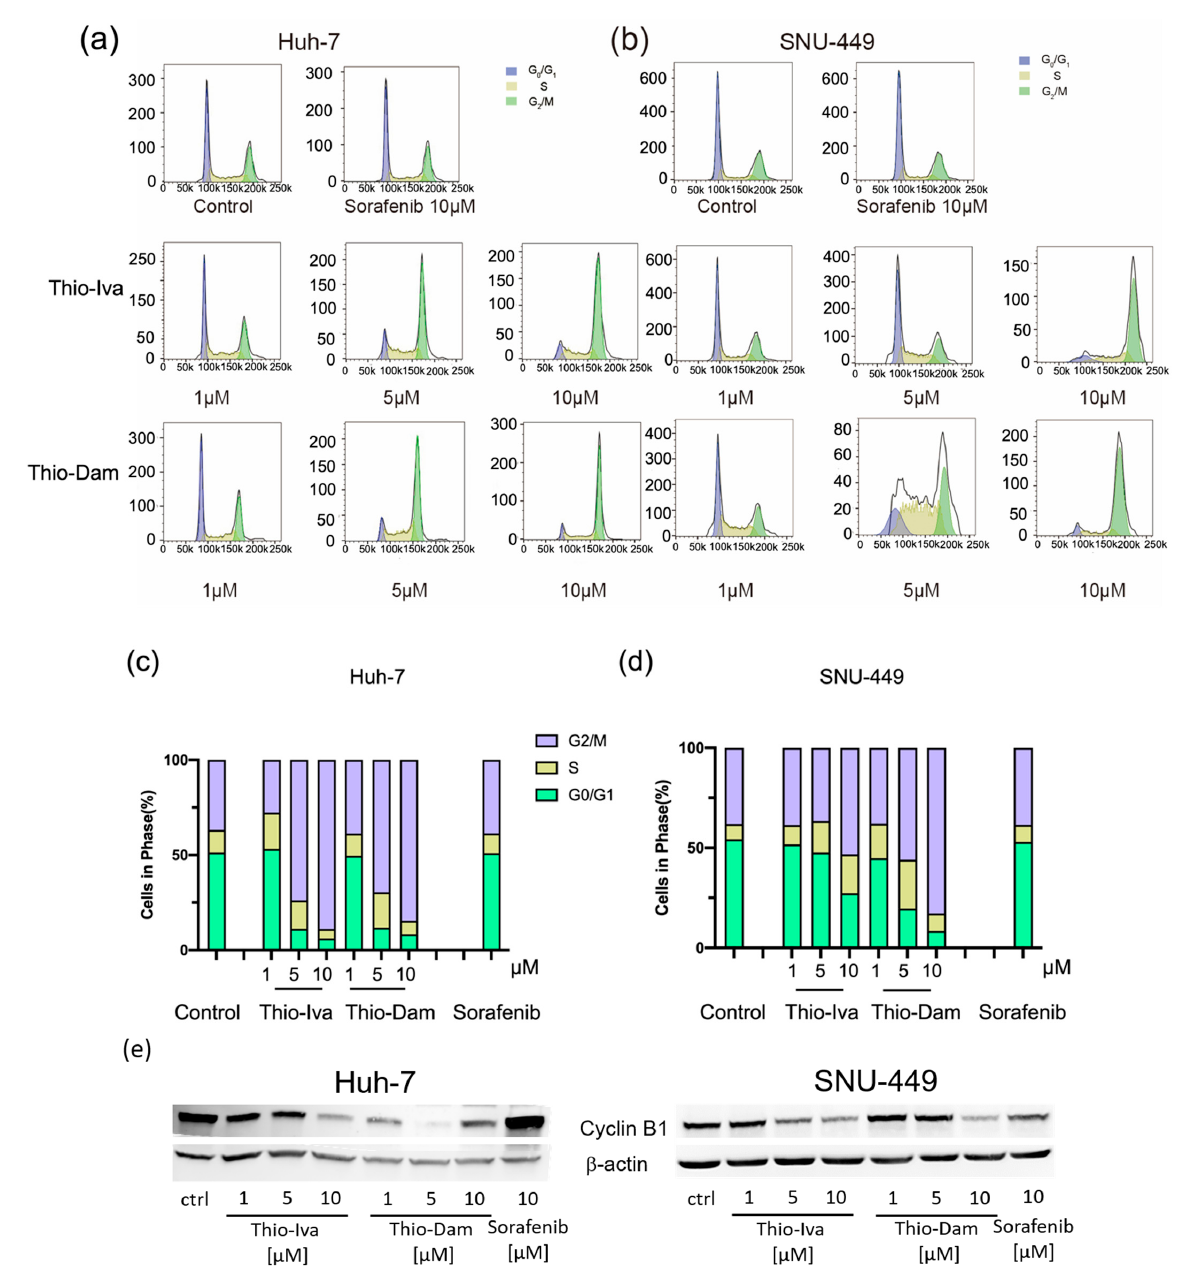
Figure 7. Flow cytometry revealed that Thio-Iva and Thio-Dam induced a pronounced G2/M arrest after 48 h in Huh-7 ( a ) and SNU-449 ( b ) cells. Quantification of the rate of the entire cell cycle; histogram shows average results for Huh-7 ( c ) and SNU-449 ( d ). All results are expressed as means ± SEM of n = 3 independent experiments. ( e ) Representative Western blots of n = 3 independent experiments showing cyclin B1 expression change in Huh-7 and SNU-449 cells upon treatment for 48 h. ß-actin was used as loading control.